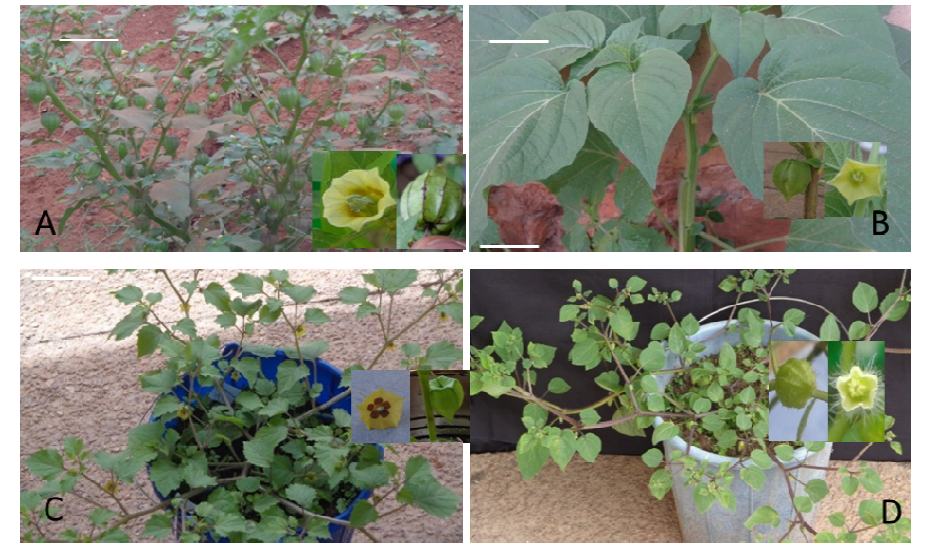
Fig. 1. Habits of Physalis species studied A. P. angulata ( inset right is flower and fruit); Scale = 10 cm; B. P. peruviana (inset right is flower and fruit); Scale = 3 cm; C. P. pubescens (inset right is flower and fruit); Scale = 10 cm; D. P. micrantha (inset right is flower and fruit); Scale = 5